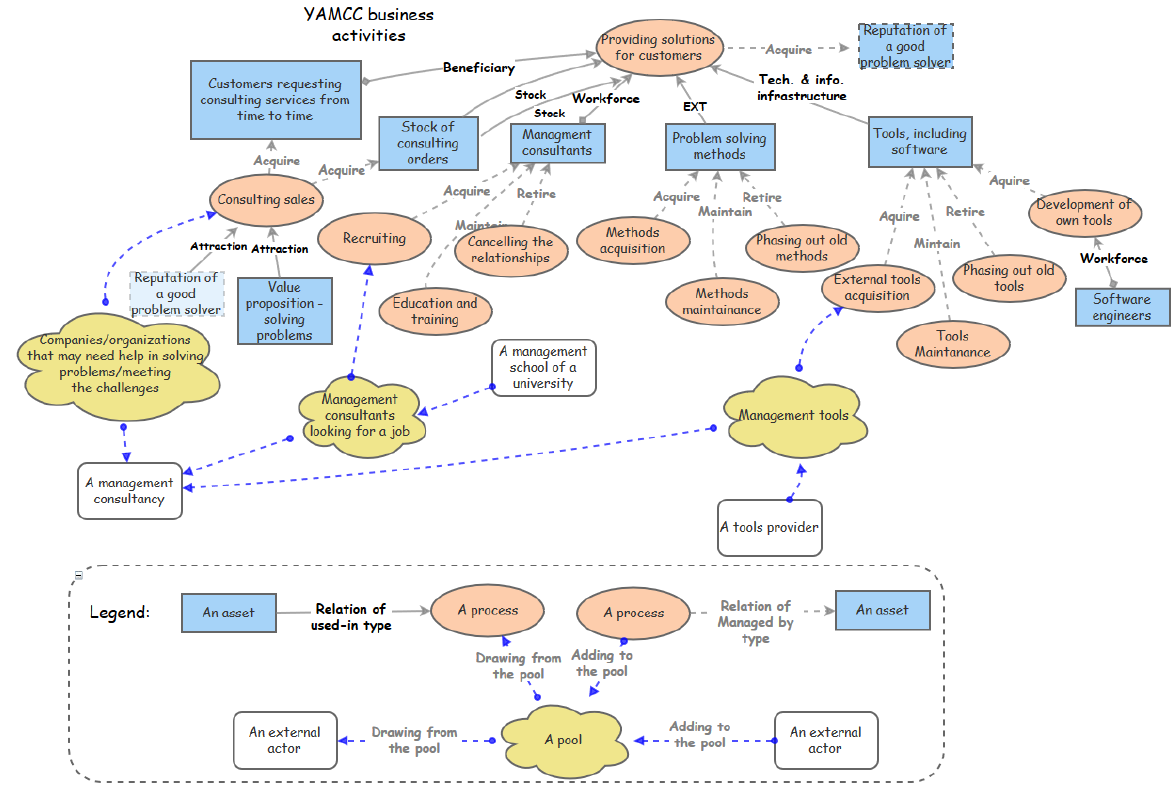
Figure 2. A fragment of a FEM for YAMCC – a management consulting company In FEM, different styles can be used for shapes to group together different kinds of processes, assets, and/or relationships between them. Such styles can include dashed or double lines, or lines of different thickness, or colored lines and/or shapes. For instance, a diamond start of an arrow from an asset to a process means that the asset is a stakeholder of the process (see the arrows “Workforce” in Figure